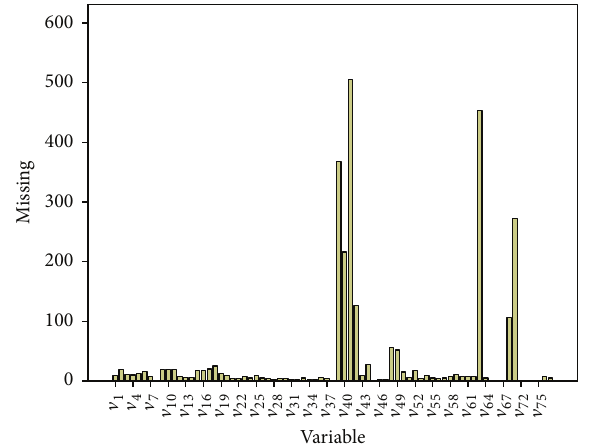
Figure 2: Bar chart of the extent of missingness showing each variable.